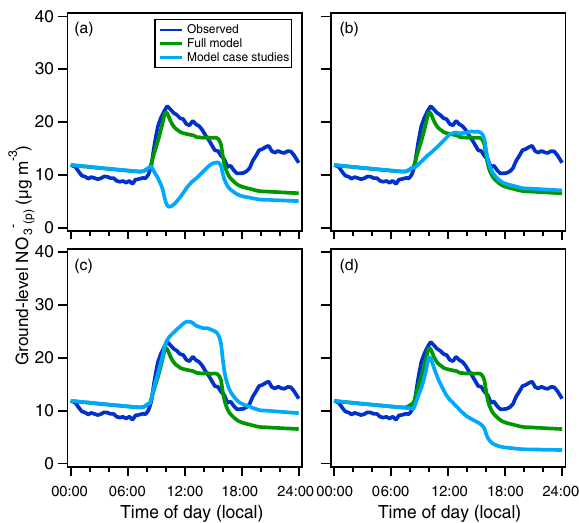
Figure 8. Model predictions of the diurnal variation in surface-level NO − under (a–c) different assumptions regarding the NO − 3 ( p ) 3 ( p ) concentration and vertical variability in the early-morning RL or (d) without daytime photochemical production of NO − . In all 3 ( p ) panels the blue curve shows the observations and the green curve shows the full observationally constrained model results (identical to Fig. 6) for the average of the 4 flight days in Episode 1. For (a– c) , the assumptions were as follows: (a) the [NO − ] RL is equal to 3 ( p ) zero; (b) the [NO − ] RL is constant with altitude and equal to the 3 ( p ) Figure 7. (a) Comparison between the observed (blue circles) and NO − at 15:00LT in the previous afternoon, corresponding to observationally constrained model-predicted (green squares) diur- 3 ( g + p ) a case of zero net production or loss; (c) the [NO − ] RL is constant nal profile of the surface NO − concentration (µgm − 3 ) for the 3 ( p ) 3 ( p ) 4 flight days (18, 20, 21 and 22 January, 2013) during Episode 1. with altitude and equal to the maximum observed [NO − ] in the 3 ( p ) Also shown is the diurnal variation in the boundary layer height early-morning RL (gray), as constrained by daytime measurements. (b) The diurnal variation in the simulated fraction of the total surface-level NO − 3 ( p ) contributed by the initial surface-level NO − (i.e., that at the sur- 3 ( p ) face level at 00:00LT), the NO − mixed down from the RL and 3 ( p ) NO − produced from daytime photochemical reactions. (c) Com- 3 ( p ) parison between the simulated diurnal profile when all processes are included (green squares, same as panel a ) and when only one NO − sink at a time is considered. The individual sinks consid- 3 ( p ) ered are only entrainment of free-troposphere air (yellow crosses) or only dry deposition of HNO 3 via the gas-phase pump (orange triangles).